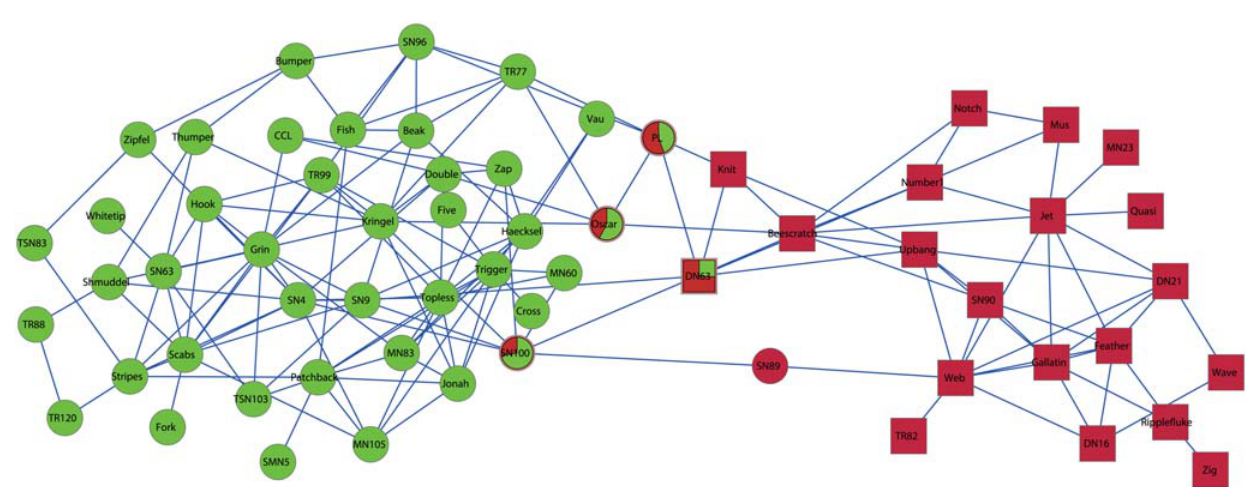
Fig 7. Two communities detected by our approach on dolphins network. Here different shapes represent the ground-truth communities, and different colors represent the communities obtained by our approach. Especially, the overlapping vertices are shown by pie vertices.